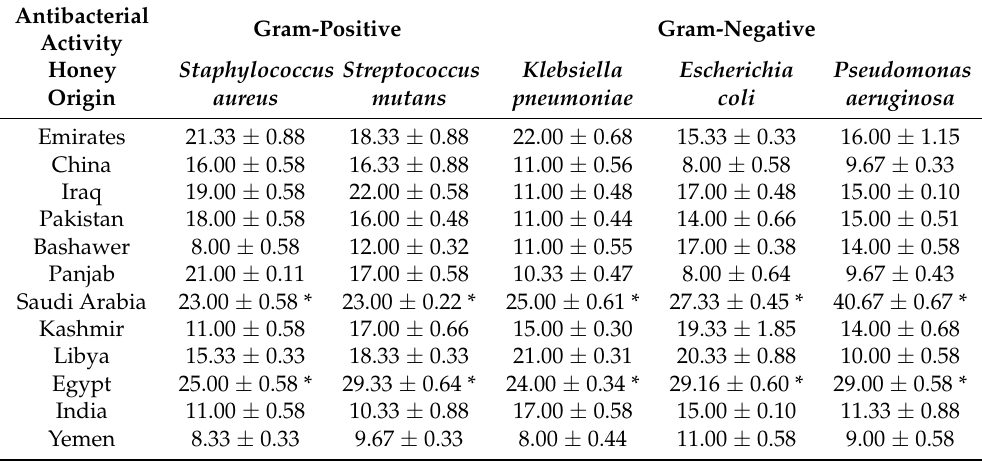
Table 6. The inhibition zone of Sidr honey against various pathogenic microorganisms by well diffusion method.